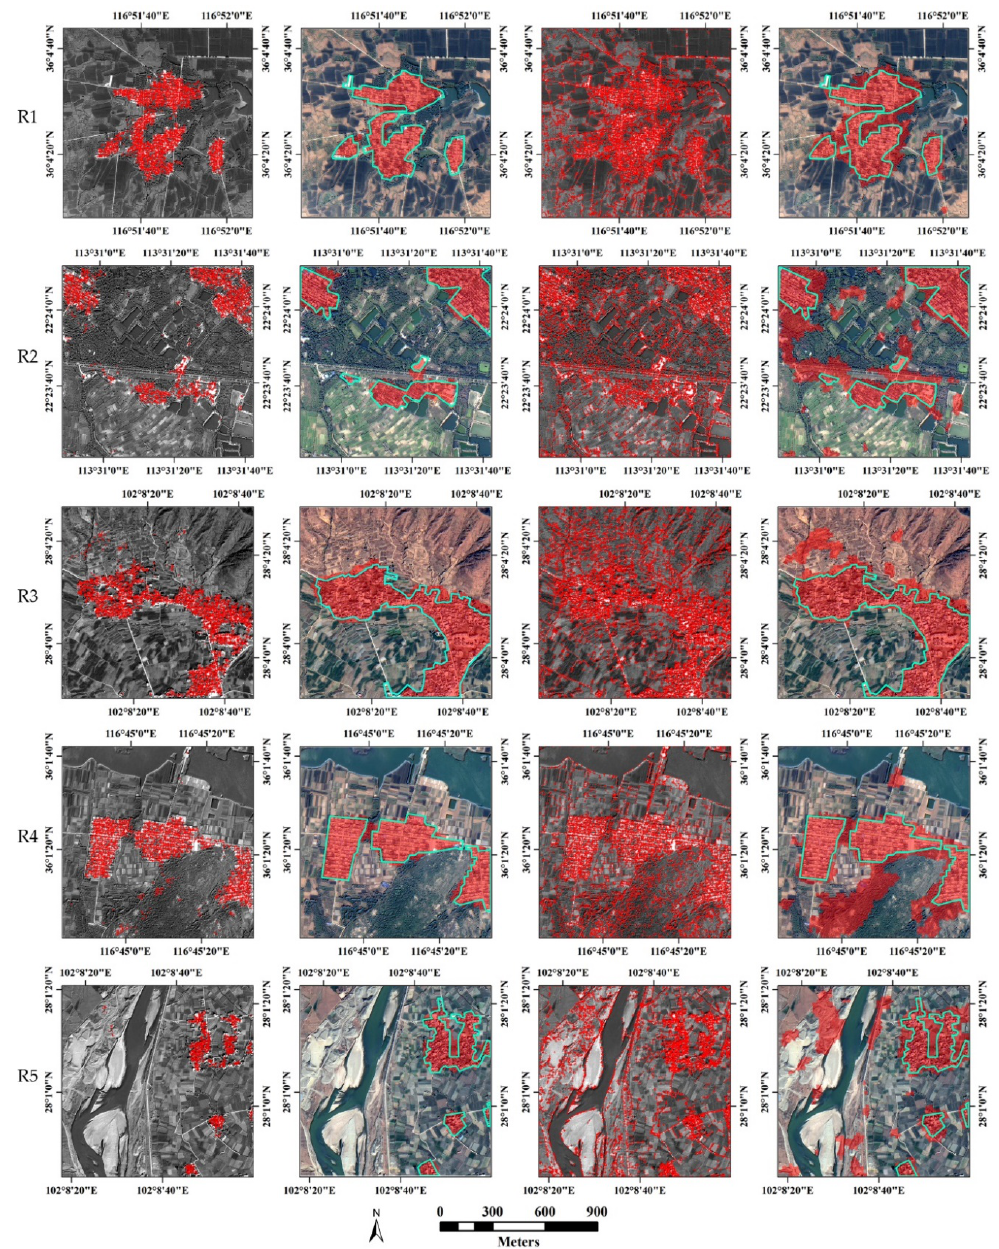
Figure 6. Results of local feature points and built-up areas. ( first column ) Local feature points (marked with red-colored points) optimized using the proposed saliency index; ( second column ) The reference data (marked with cyan-colored polygons) and built-up areas (marked with red-colored area) extracted using the optimized local feature points; ( third column ) Originally detected local feature points (marked with red-colored points); ( fourth column ) The reference data (marked with cyan-colored polygons) and built-up areas (marked with red-colored area) extracted using the originally detected local feature points.